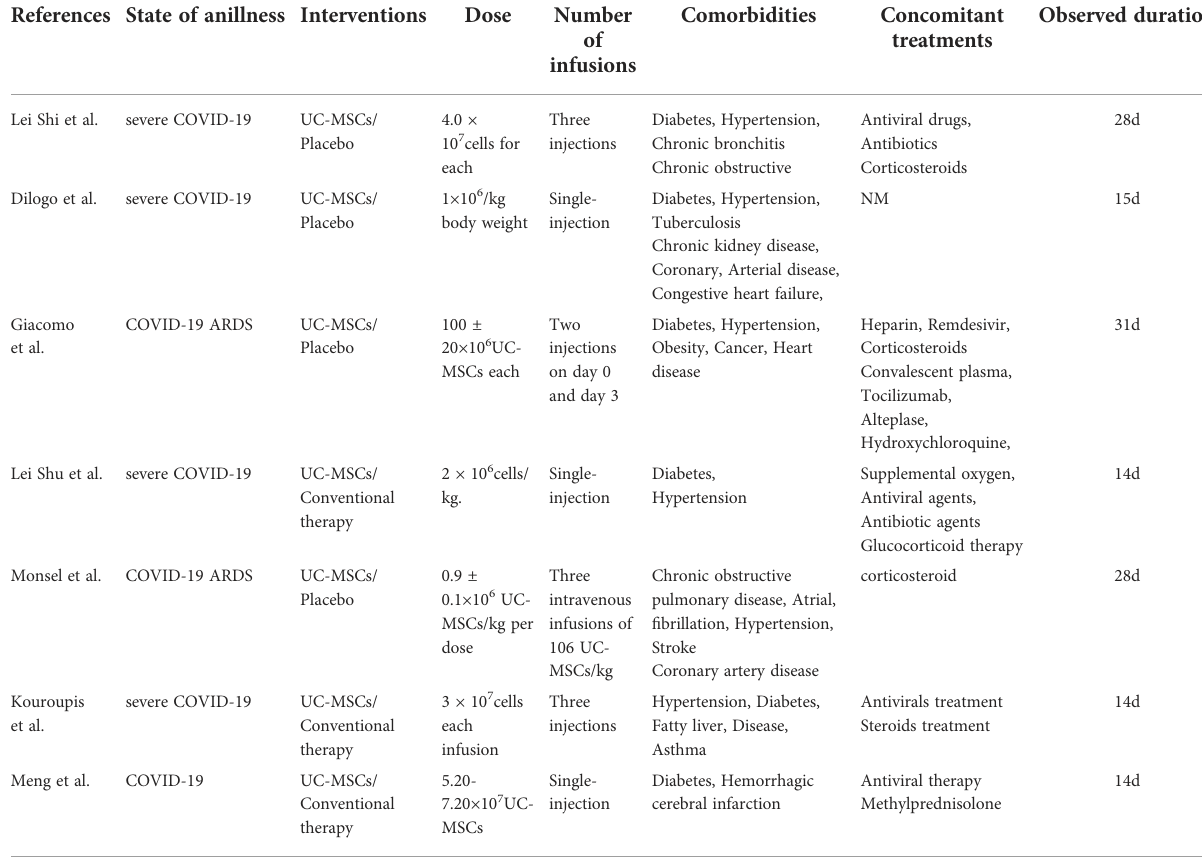
TABLE 3 Baseline patient characteristics.